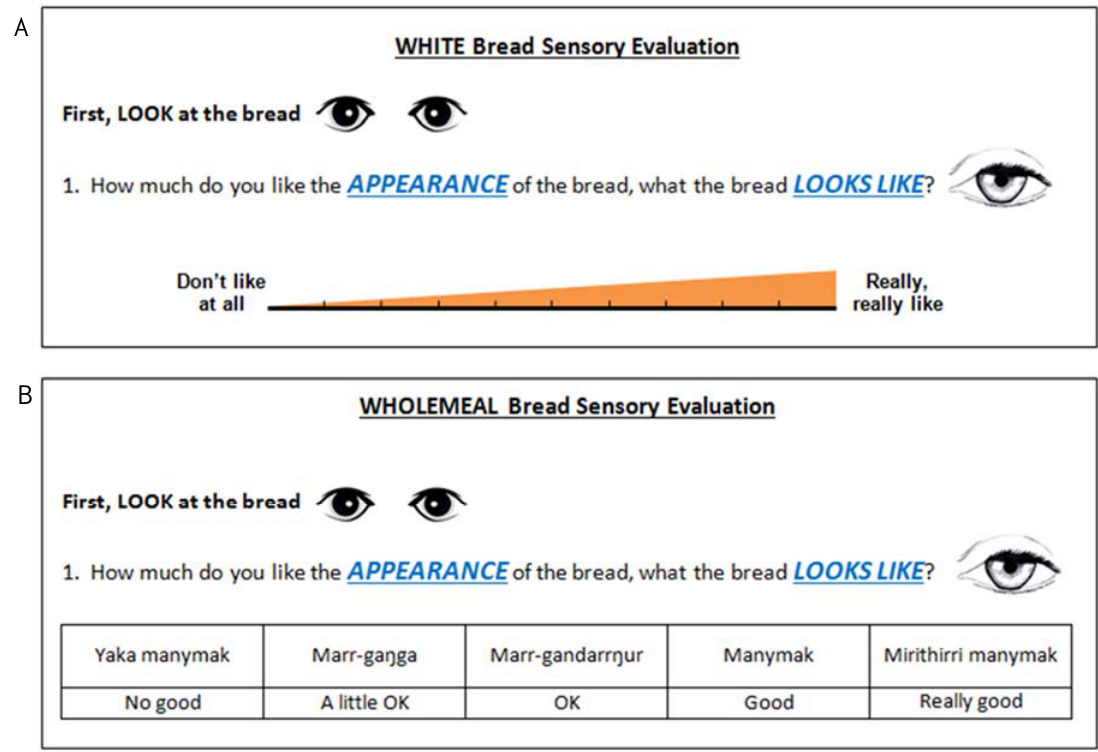
Figure 1. Scales used in white ( A ) and wholemeal ( B ) acceptability testing.